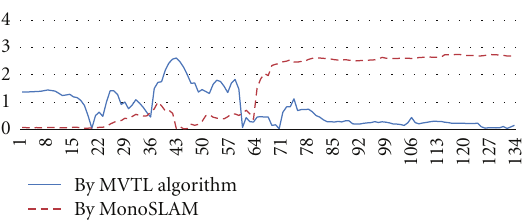
Figure 9: The comparison of the target 2 depth errors (meter) between MVTL and MonoSLAM [18] in Path